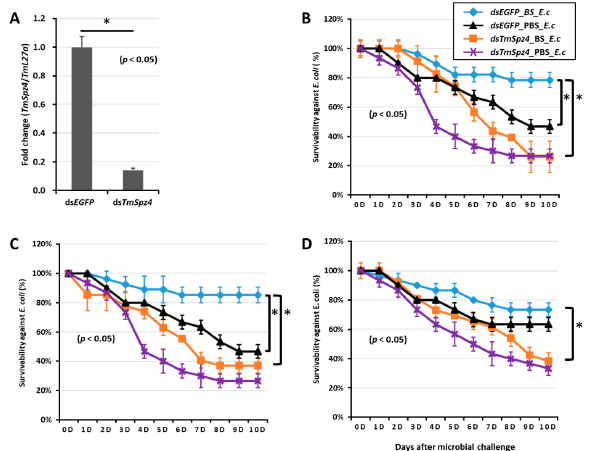
Figure 9. Survivability of T. molitor larvae against E. coli (E.c) after TmSpz4 gene silencing and biosurfactant injection. The TmSpz4 gene was silenced, and the silencing efficiency of TmSpz4 mRNA was measured by qRT-PCR at 5 d post-injection ( A ). Then, biosurfactants (BS) including fengycin ( B ), iturin A ( C ), and rhamnolipid ( D ) were separately injected into the gene-silenced larvae. E. coli was then injected into the gene-silenced and biosurfactant-injected larvae. ds EGFP and 1XPBS were injected as control for the gene- and biosurfactant- or microbe-injected groups, respectively. The data represent the mean of three biological replicate experiments. * significant differences between ds TmSpz4 - and ds EGFP -treated groups of biosurfactant- and PBS-injected larvae ( p < 0.05).